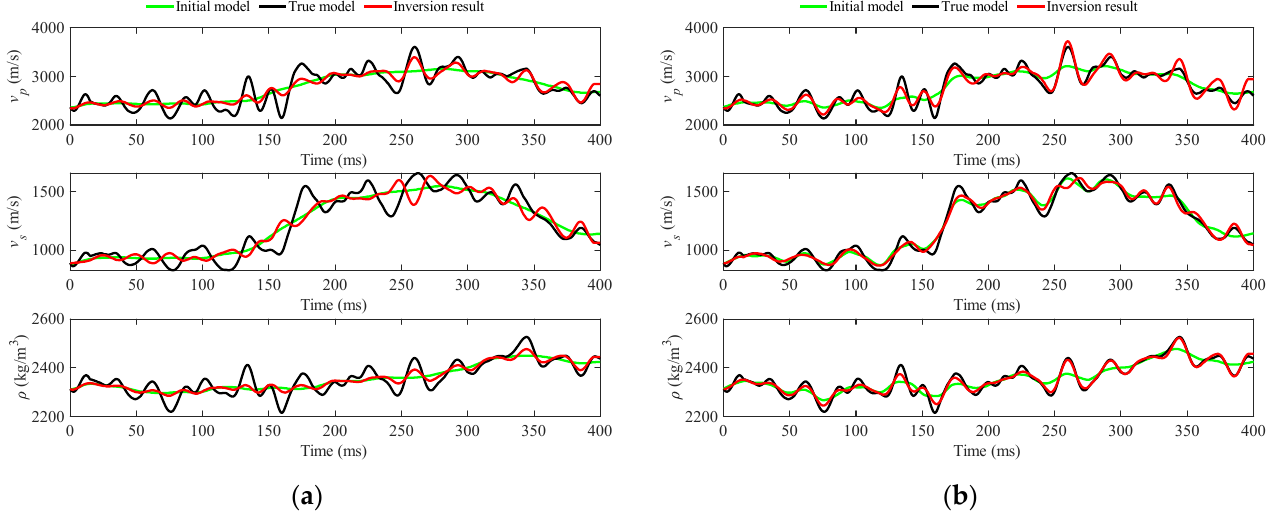
Figure 17. The comparison between the borehole data and the inversion results of v p , v s , and ρ by ( a ) KI models and ( b ) FM-NLM models.